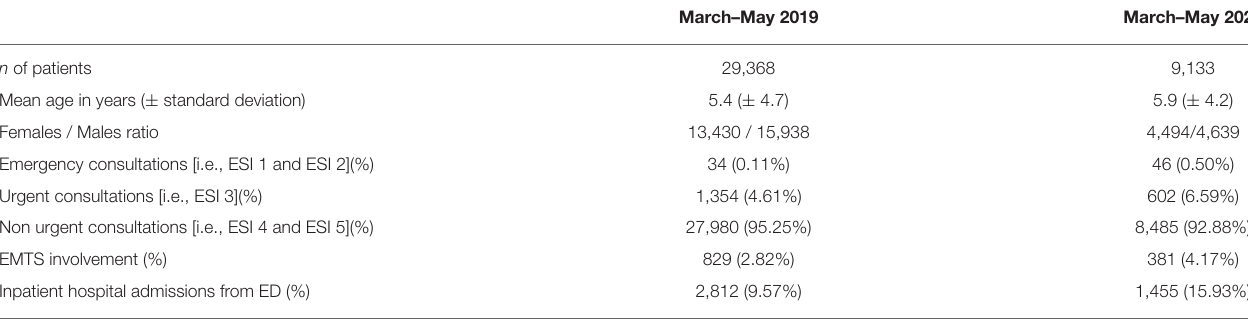
TABLE 1 | Patients demographics in the two considered periods.